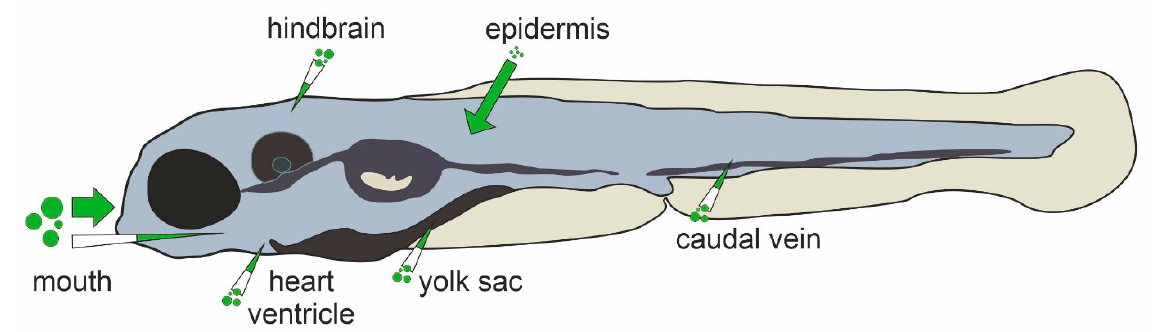
Figure 1. Possible compound application routes for larval zebrafish. Uptake routes which predominate during exposure by immersion are indicated by arrows, sites for compound microinjection by injection needles.